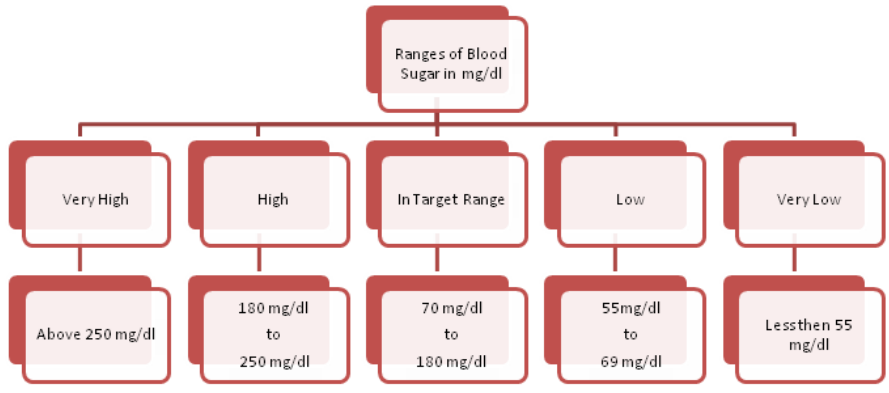
Figure 3. Ranges of Blood Sugar.